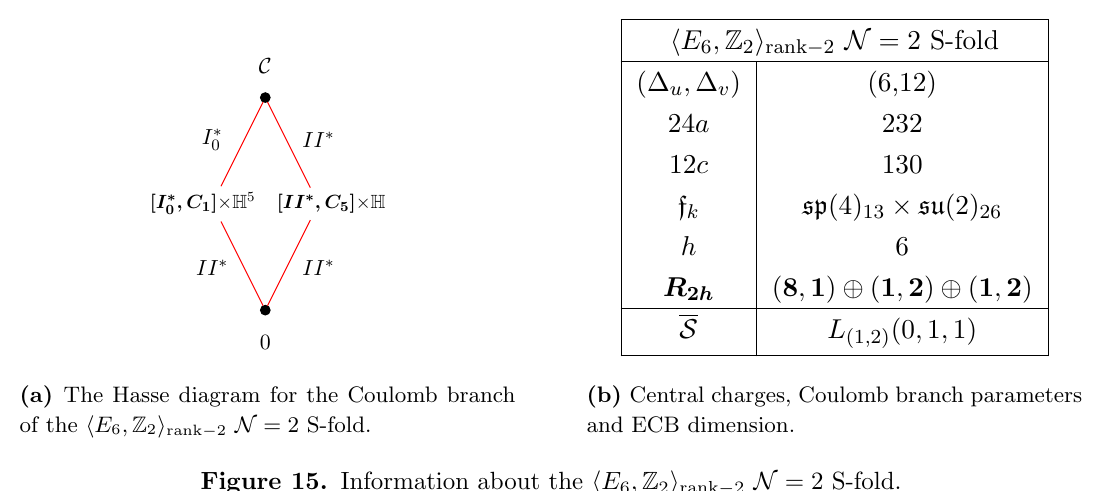
Figure 15. Information about the h E 6 ; Z 2 i rank (cid:0) 2 N = 2